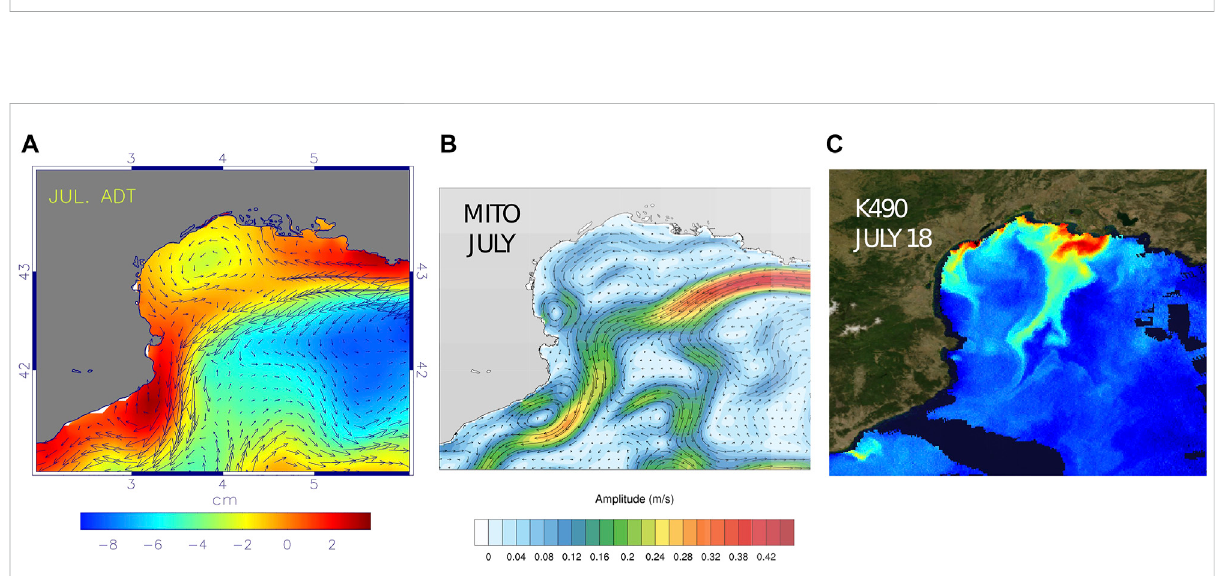
FIGURE 8 Average July surface circulation in the area of the Gulf of Lion: (A) ADT (colors), with a geostrophic reconstruction of the circulation superimposed (AVISO, satellite data); (B) MITO currents at 10 m; (C) map of K490 (coef fi cient of light extinction at 490 nm) measured from satellite, for July